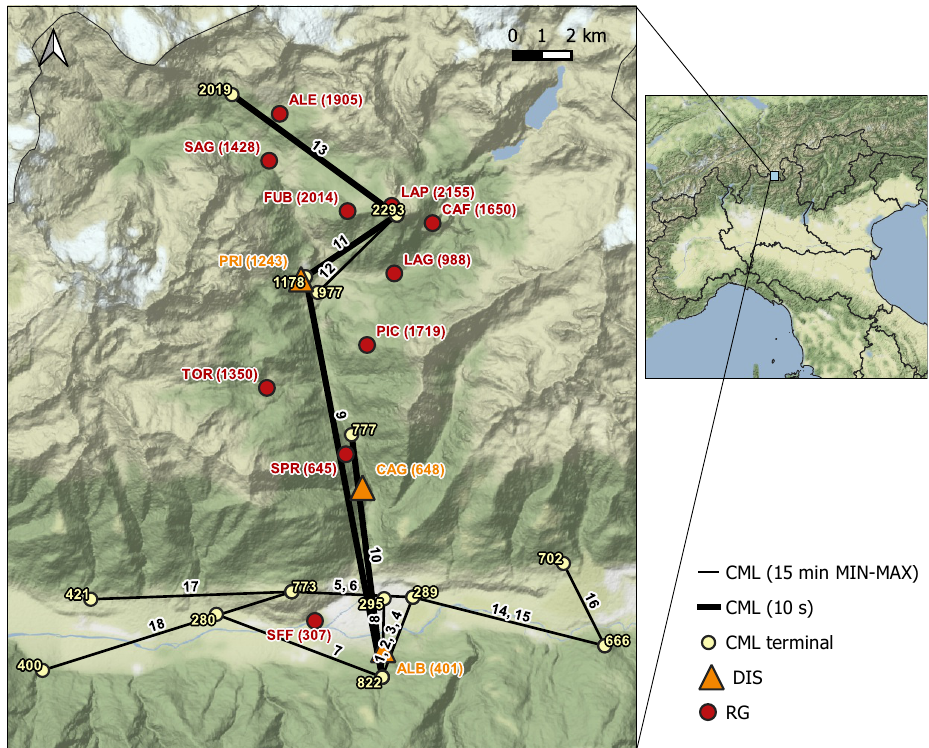
Figure 1. Sensors’ locations in the Valmalenco valley. CML are identified by numbers from 1 to 18, and DIS (orange) and RG (red) by three-character codes. In brackets are the altitudes (in m a.s.l.) at which sensors are located. The yellow numbers, instead, are the altitudes of CML terminals. The bold lines highlight the links for which nearly instantaneous power measurements (every 10 s) are